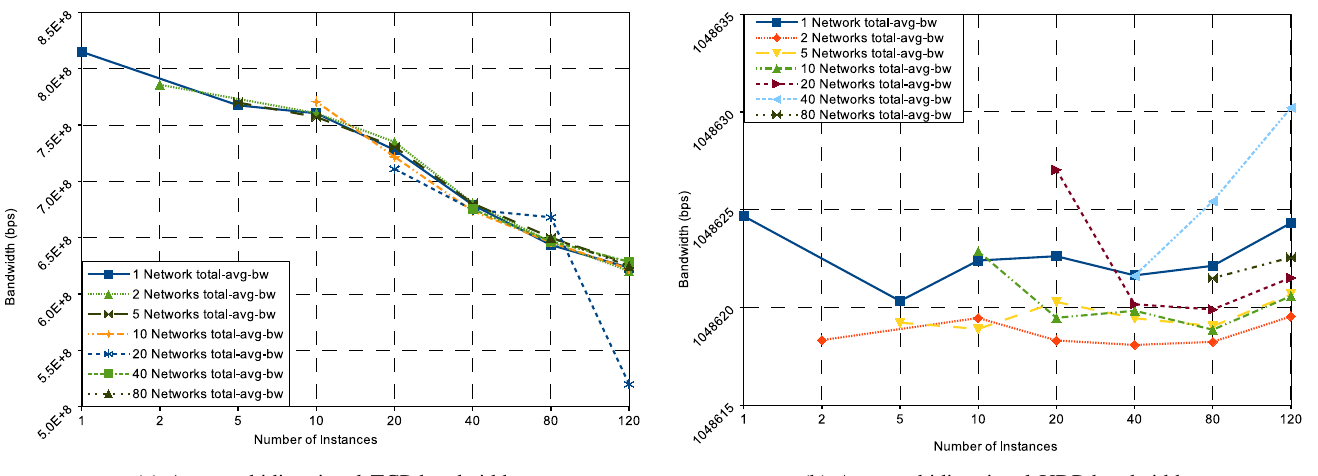
Fig. 6: Average bidirectional TCP and UDP bandwidth for DNB